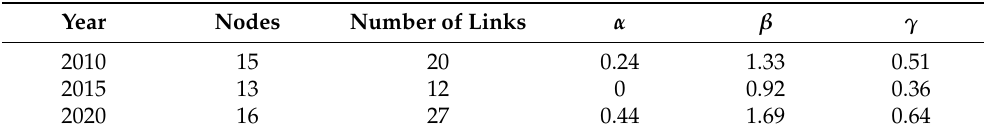
Table 6. Evaluation of BI network